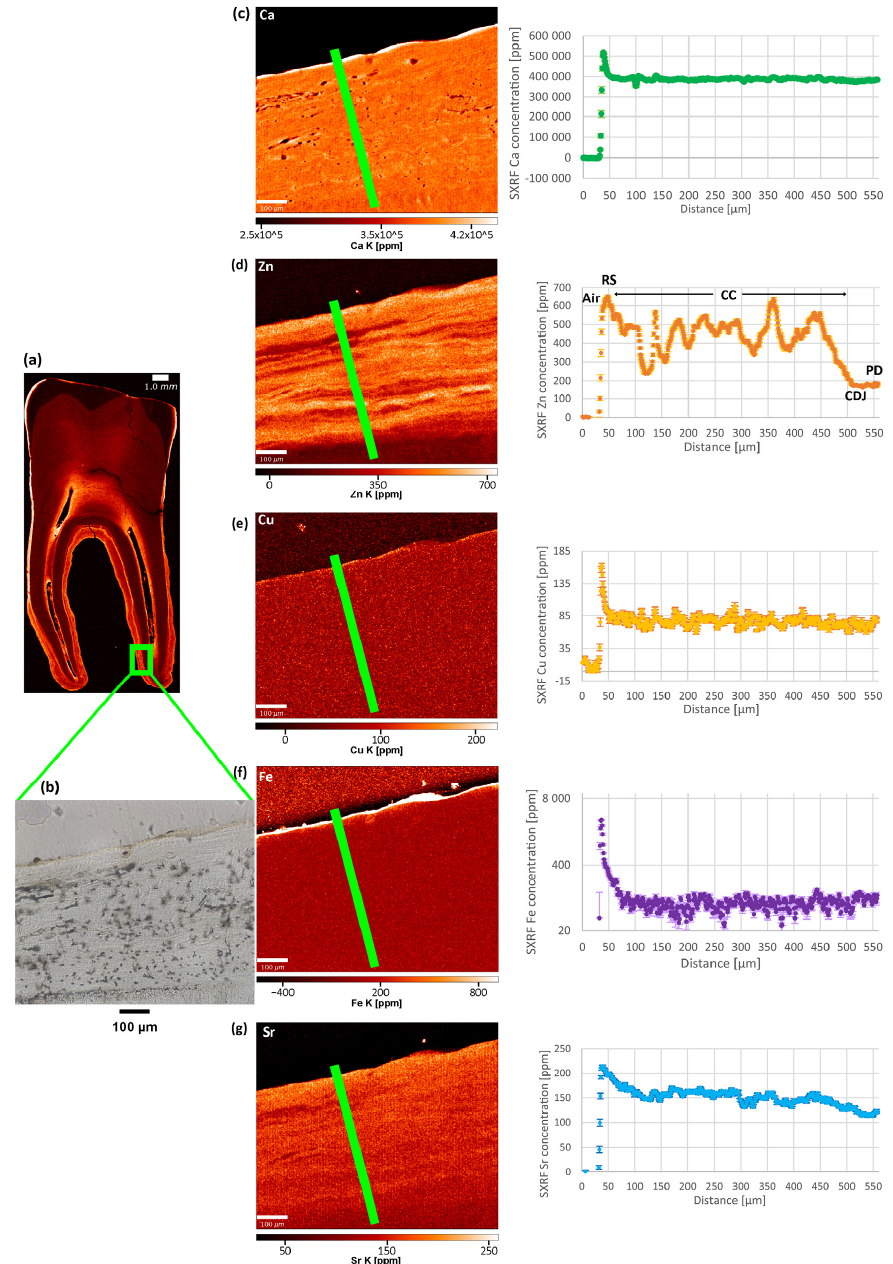
Figure 3. Distributions of elements potentially affected in leprosy (Ca, Zn, Cu, Fe) and Sr in Næstved 268M. The region of interest in the cellular cementum (green frame on the Zn overview map ( a )) shows few identifiable increments in TLM ( b ). The SXRF data were collected on a scan at 1 µ m, for each element of interest, along the green path ( c – g ). Elemental concentrations (in ppm) were then plotted against distance along the path in µ m. As depicted on the Zn map, the path starts in the air (“Air”), reaches the root surface (RS), the cellular cementum (CC), the cementum-dentine junction (CDJ), and ends in the primary dentine (PD). Calcium ( c ) shows little variation, although a slight regular pattern may be visible on the Ca map. The Zn map ( d ) displays the clearest pattern of alternating enrichments and depletions, while Cu ( e ) and Fe ( f ) show uniform levels throughout the cementum. A subtle pattern recalling that of the Zn map can be observed in the Sr map ( g ). Note that a logarithmic scale was used to plot Fe, as the root surface enrichment at ~3000 ppm obscured the visibility of the pattern within the cementum at ~40–100 ppm. Graphic programs used: Adobe Photoshop CS6 and Adobe Illustrator